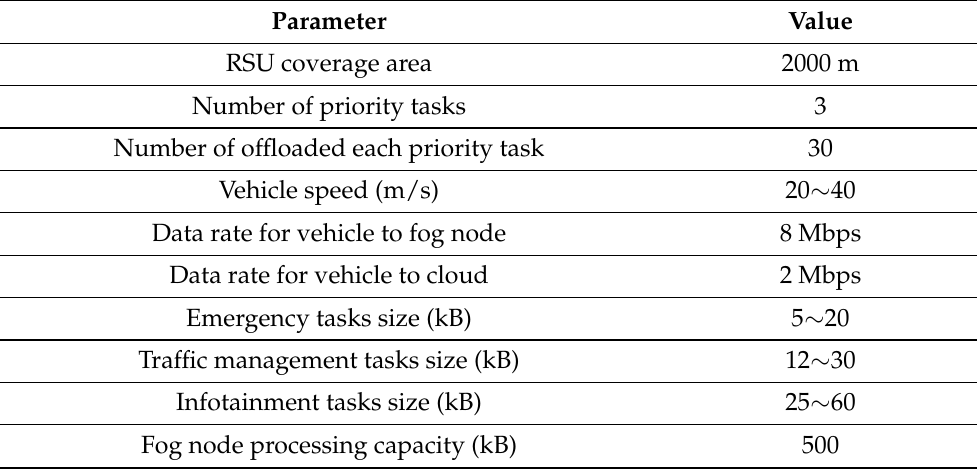
Table 1. Simulation